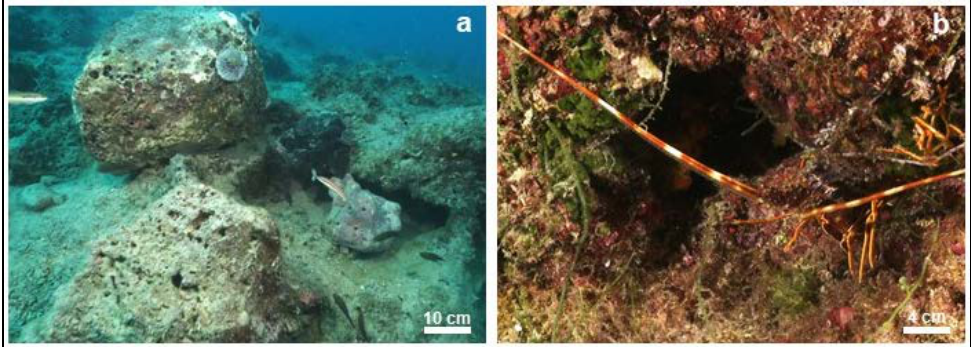
Figure 2. Disturbances at the study sites: ( a ) traces of Lithophaga lithophaga harvesting at ZH and ( b ) presence of Caulerpa cylindracea at WE. ( b ) presence of Caulerpa cylindracea at